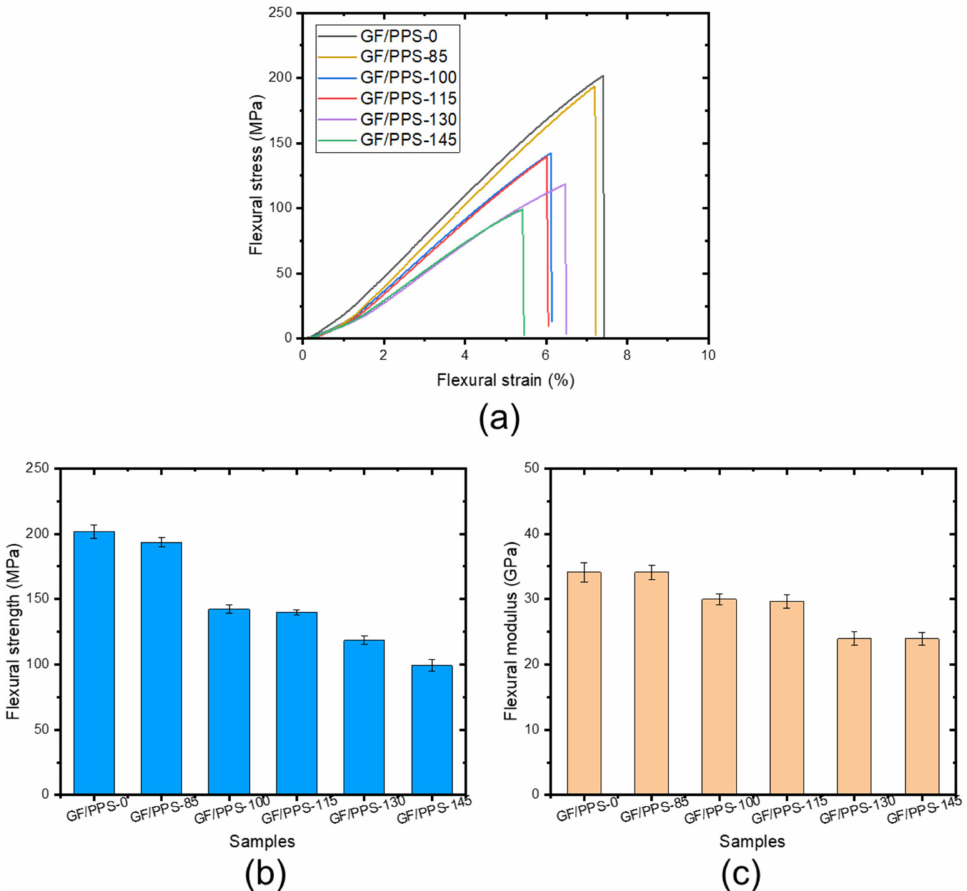
Figure 5. Flexural stress–strain curves of the samples ( a ), flexural strength ( b ), and flexural modulus ( c ) of the aged samples as a function of